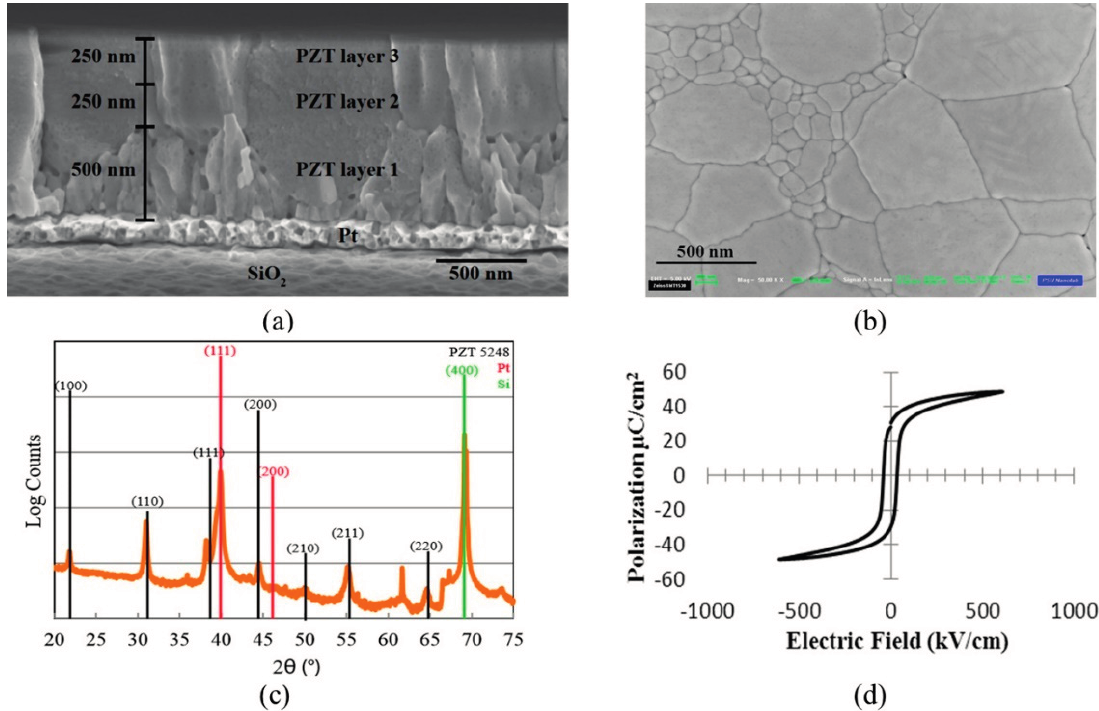
Figure 2. FESEM images of ( a ) cross-sectional and ( b ) top surface of PZT thin film; ( c ) XRD pattern of the PZT film with the absence of PbO (2 θ = 29.09°) and pyrochlore/fluorite (2 θ = 29.55°); ( d ) hysteresis loop of the sputtered PZT thin